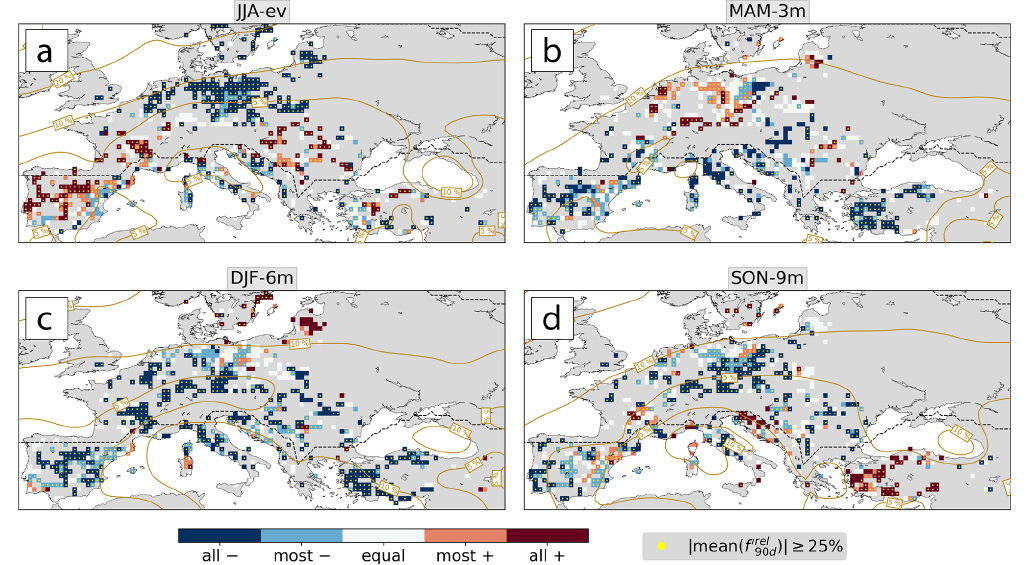
Figure E2. The same as Fig. 7 but for the relative cyclone frequency anomaly f (cid:48) rel 90d (C) in (a) JJA-ev, (b) MAM-3m, (c) DJF-6m, and (d)